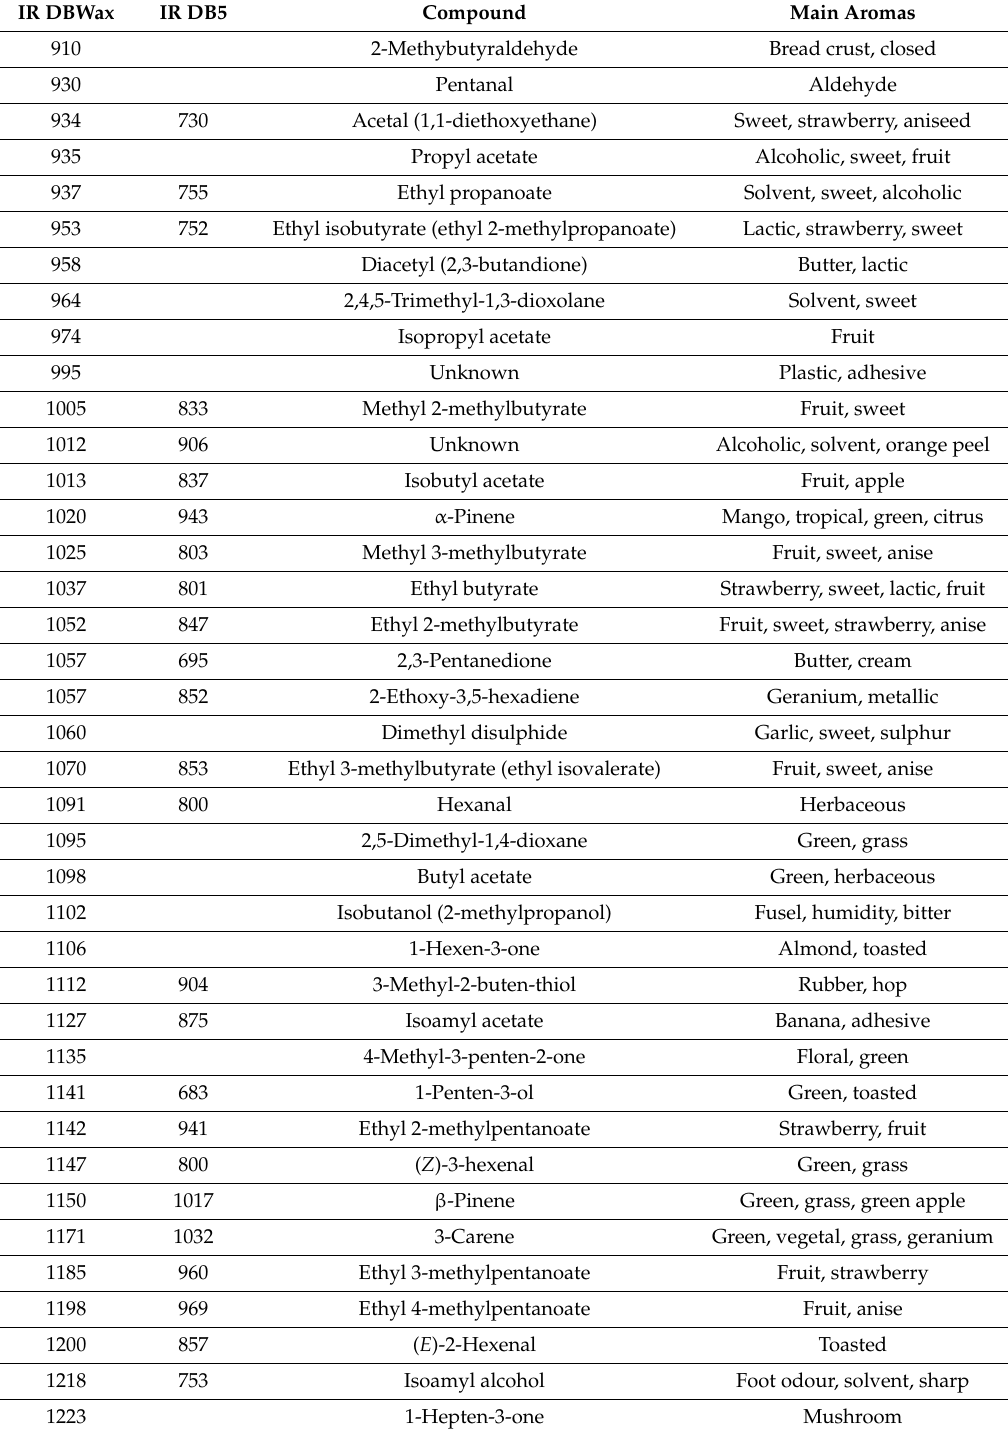
Table 3. Odour zones detected in wine extracts in a GC-O system in two chromatographic